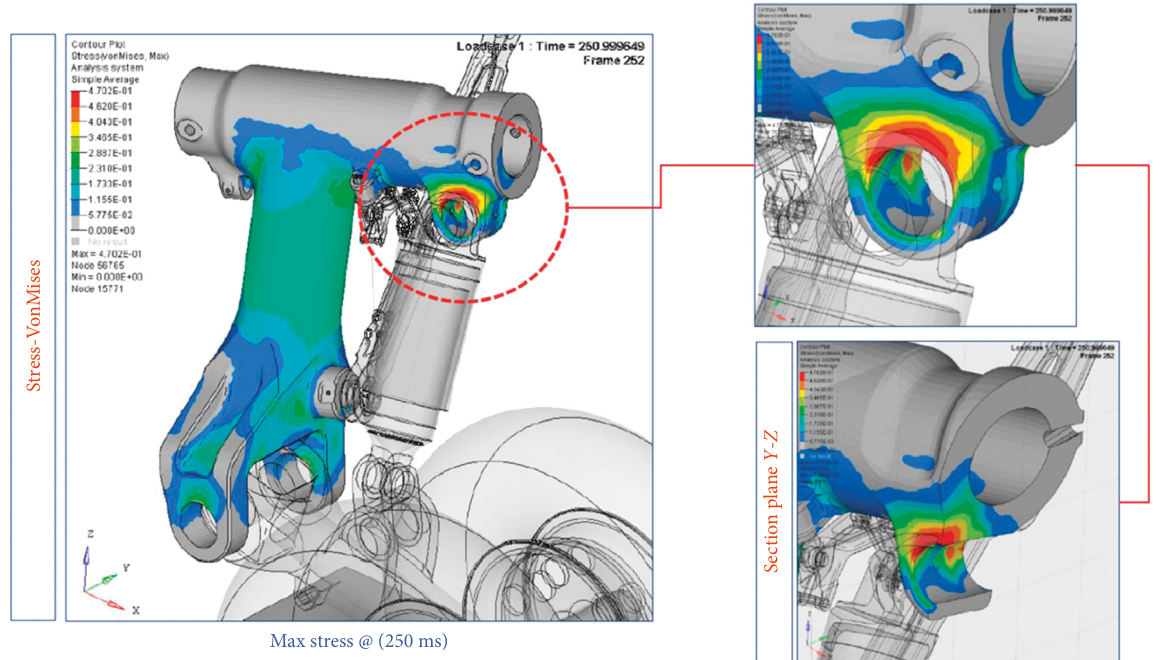
Figure 34: von Mises stress (GPa) contour plot for the main fitting.